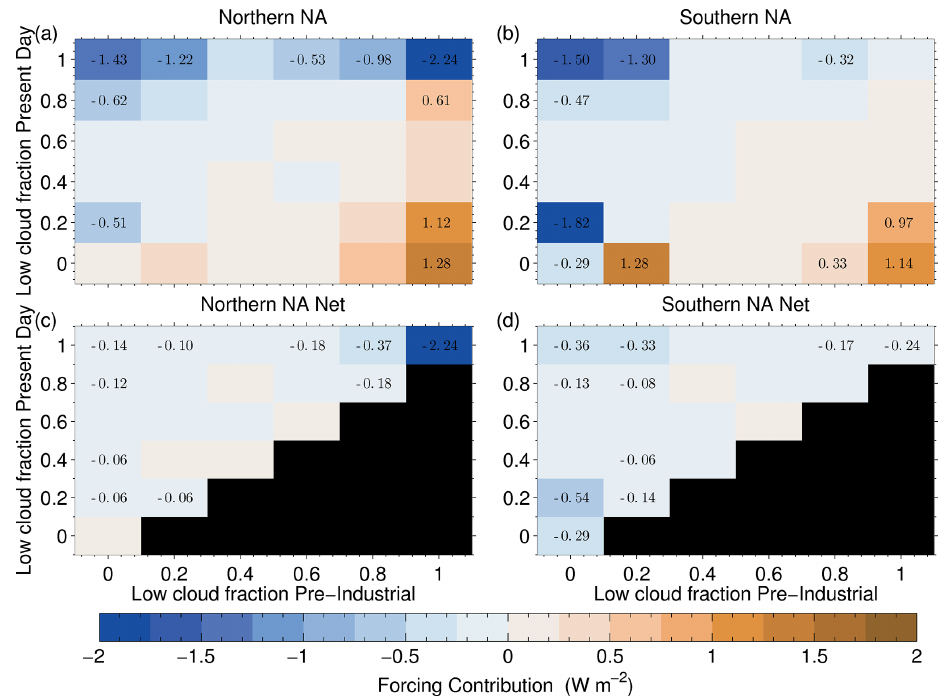
Figure 19. As for Fig. 18 except plotted as a function of the different combinations of areal low cloud fraction of the PI and PD